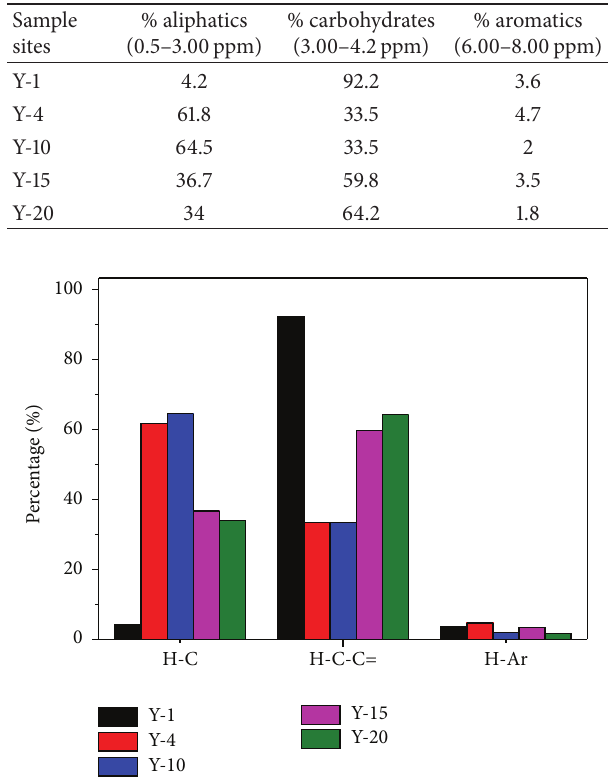
Figure 5: The relative abundance of each type of protons, estimated as the partial integrals of the spectra reported in Figure